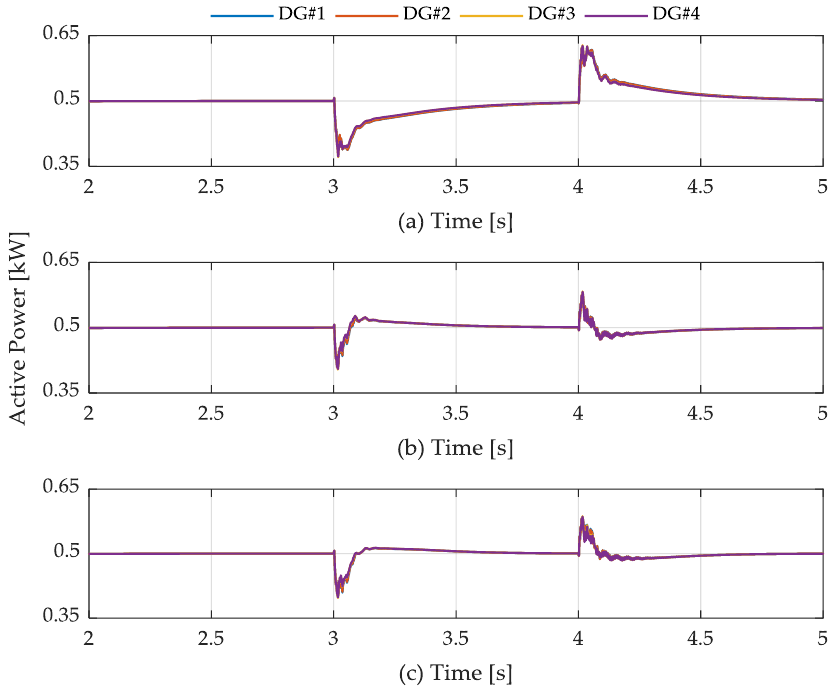
Figure 9. Output current of each DG: ( a ) without LVRT; ( b ) centralized method; ( c ) proposed method. Energies 2018 , 11 , x